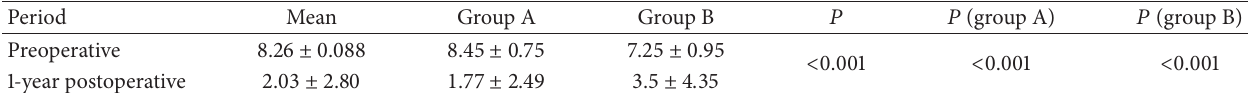
Table 1: Comparison of pretreatment and posttreatment pain.